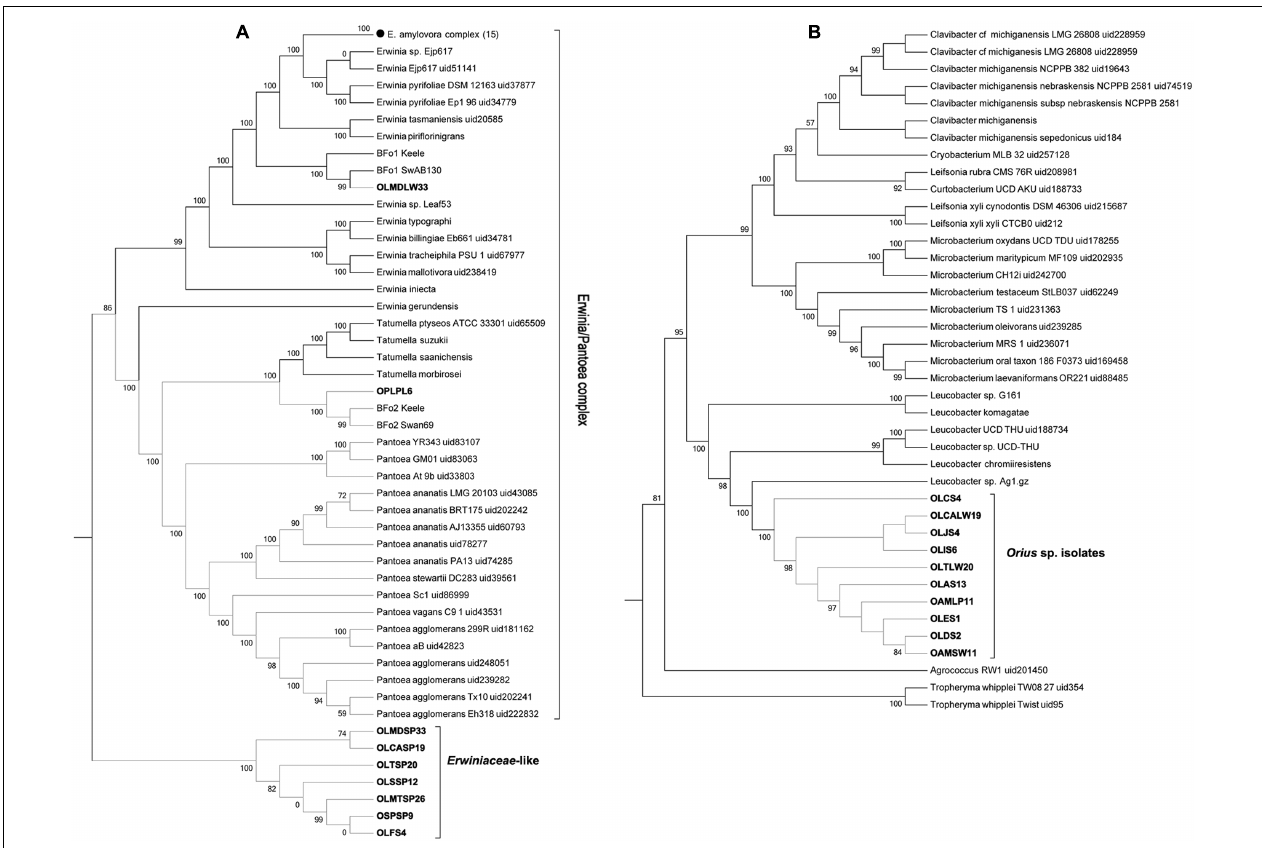
FIGURE 3 | Multilocus phylogenetic distribution of Orius -derived Erwiniaceae -like (A) and Leucobacter -like (B) isolates, obtained using PhyloPhlan. Collapsed nodes were used for simplicity, with number of genomes per node indicated within brackets.